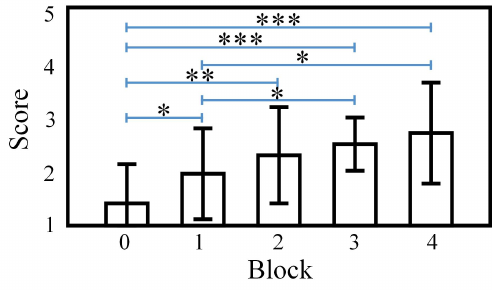
Figure 3. Statistical results of SVF scores for each viewing block. Block 0 refers to the assessment of SVF right before the formal stage begins. *** p < 0.001, ** p < 0.01, * p <